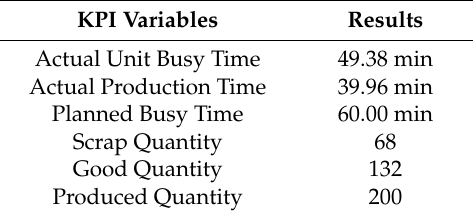
Table 2. KPIs Variables after executing an example production